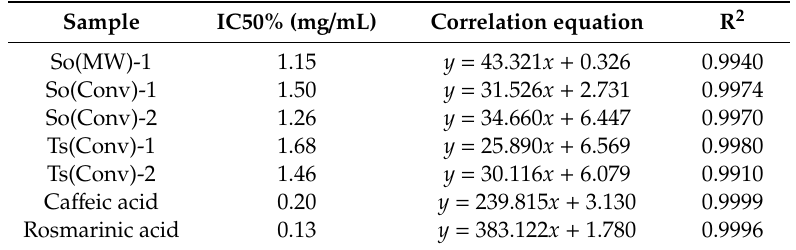
Table 3. Radical scavenging activity of polyphenolic extracts assessed by DPPH assay.